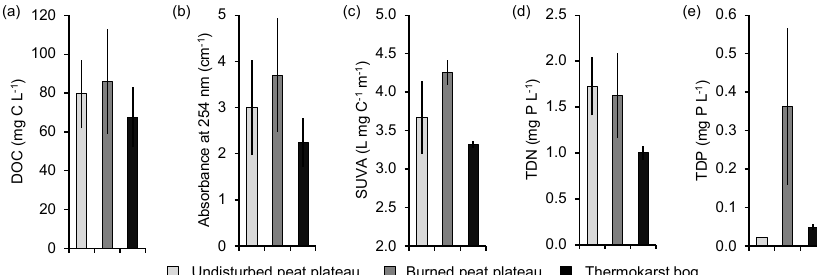
Figure 7. Porewater characteristics at undisturbed peat plateaus, recently burned peat plateaus, and thermokarst bogs; (a) dissolved organic carbon (DOC), (b) decadal absorbance at 254nm, (c) specific UV absorbance at 254nm (SUVA), (d) total dissolved nitrogen (TDN), and (e) total dissolved phosphorous (TDP). Error bars indicate 1 SD based on three samples collected in early June, late July, and early September. The partially burned peatland site with both undisturbed and burned peat plateaus is located just outside the Notawohka catchment.